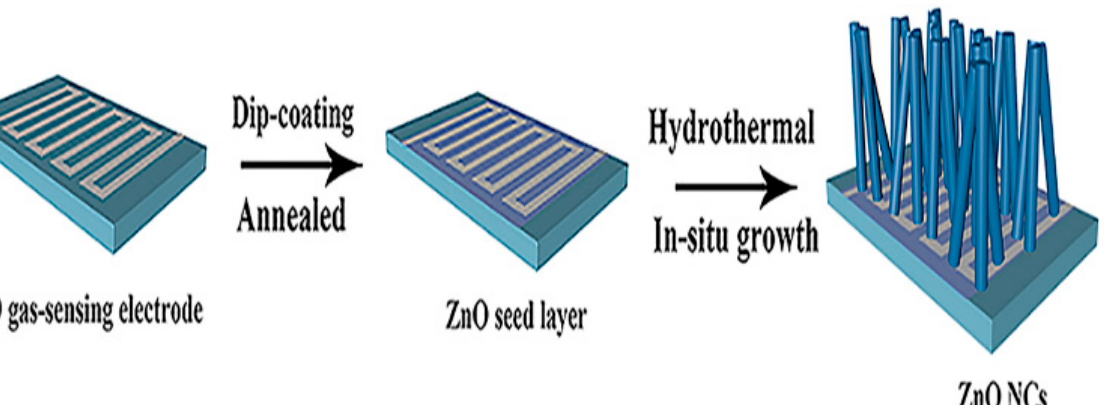
Figure 16. Diagram of the preparation process of in-situ growth of ZnO on FTO gas-sensing electrode [80].